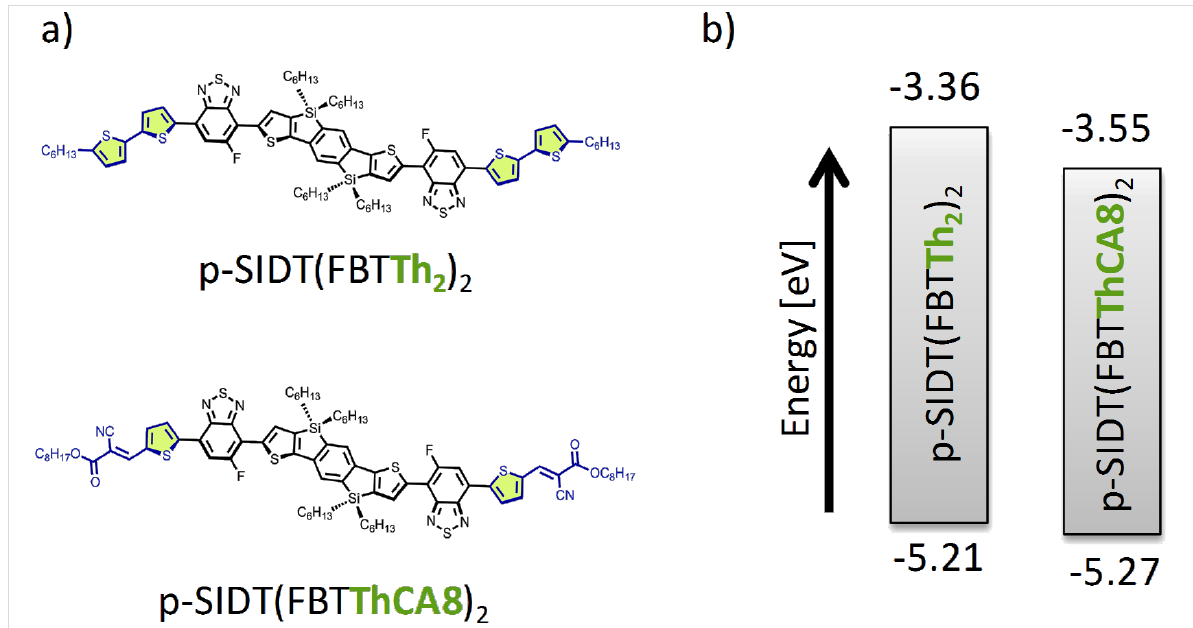
Figure 1: a) Molecular structures and b) energy levels of p-SIDT(FBTTh 2 ) 2 and p-SIDT(FBTThCA8) 2 highlighting the modification of the end